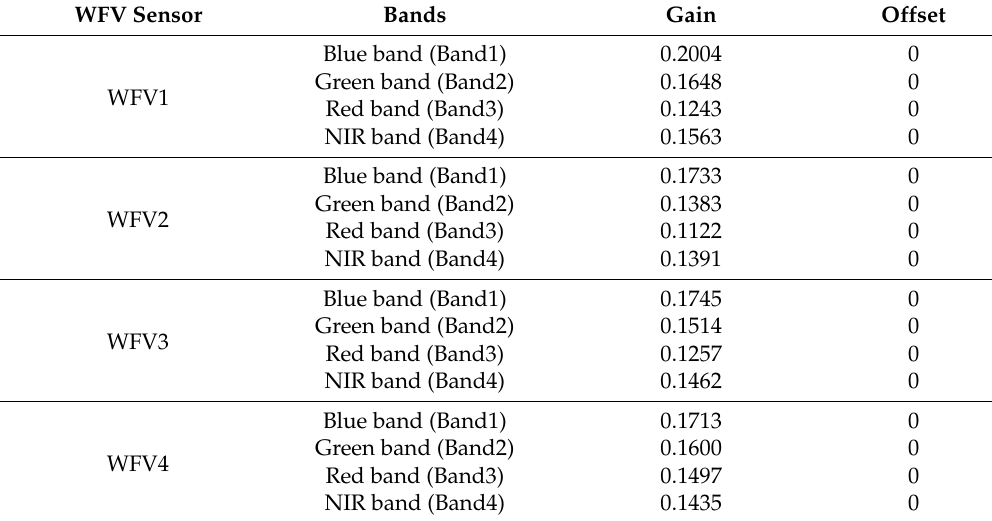
Table 2. The calibration coefficients of GF-1 WFV data in